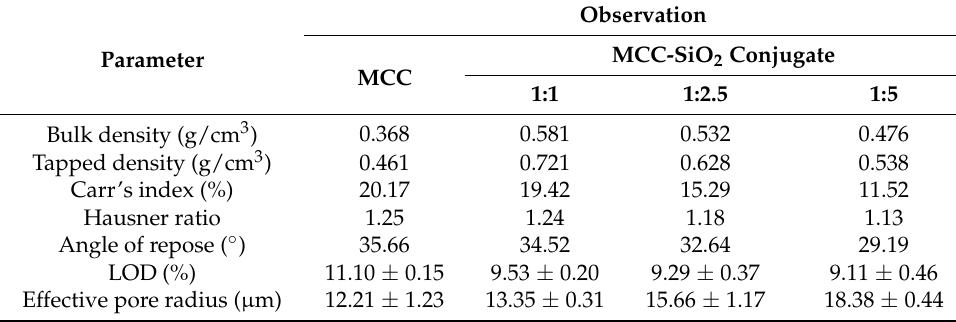
Table 2. Micromeritic properties for MCC and MCC-SiO 2